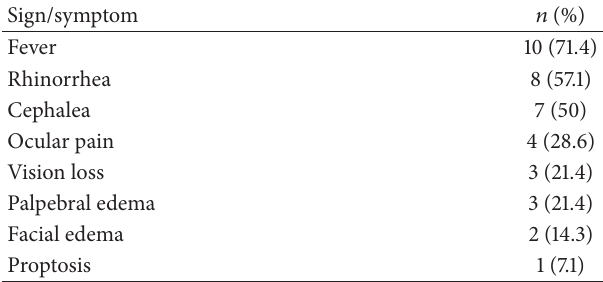
Table 2: Presenting signs and